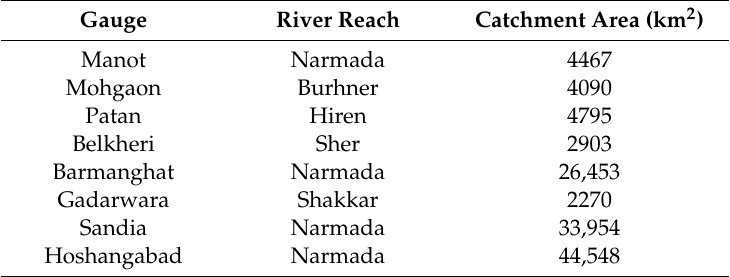
Table 3. Information on the gauged subcatchments used for this study, based on Gupta and Chakrapani [4] and Jain et al. [65].